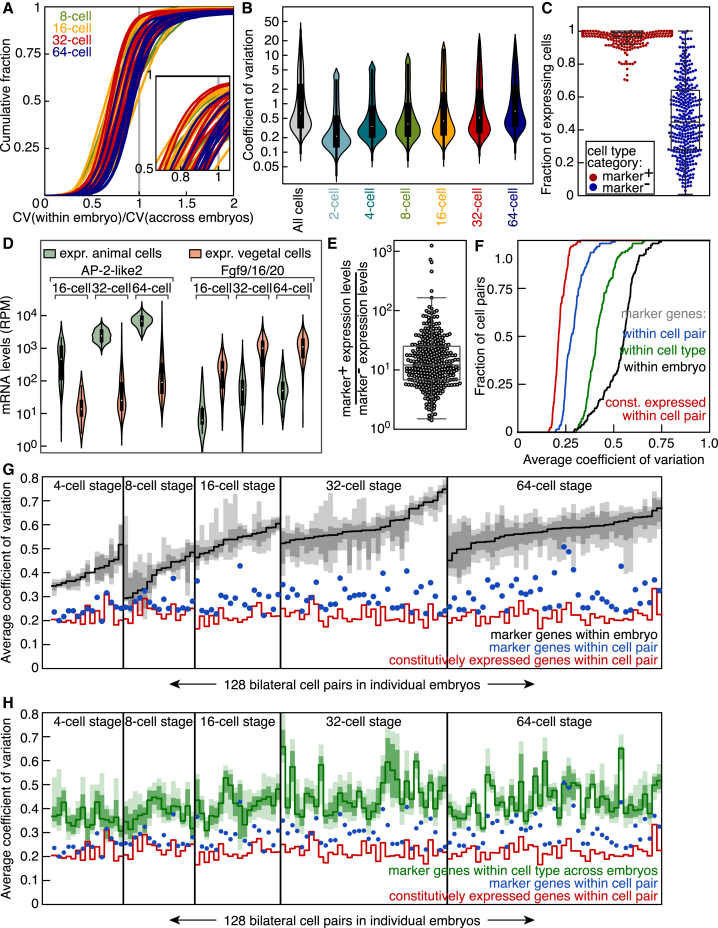
Precision of Gene Expression Regulation(A) Cumulative distribution of the coefficient of variation of expression levels within an embryo divided by the coefficient of variation of expression levels across embryos. Green, orange, red, blue lines are data from 8-, 16-, 32-, and 64-cell embryos, respectively. Inset, zoom of the plot.(B) Coefficient of variation of gene expression levels computed across single cells of embryos of the same stage.(C) Fraction of cells expressing marker genes that classify cell types (STAR Methods).(D) Violin plots of AP-2-like2 and Fgf9/16/20 expression levels in cells with detectable expression.(E) Comparison between marker gene expression levels in cells with detectable expression belonging to marker-positive or -negative cell types.(F) Cumulative distribution of the average coefficient of variation of expression levels of marker genes in bilaterally symmetric cell pairs (blue), in cells belonging to the same cell type (green), in cells belonging to the same embryo (black), and of the levels of genes with constitutive expression (red).(G and H) Average coefficient of variation of the expression levels of marker genes in two equivalent cells of the bilaterally symmetric embryo (blue dots) compared to cells randomly sampled in the same embryo ([G], black), compared to cells of the same cell type randomly sampled across embryos ([H], green), or compared to genes with constitutive expression in that same cell pair (red). Dark gray and green shade, interquartile range; light gray and green shade, 10%–90% range.